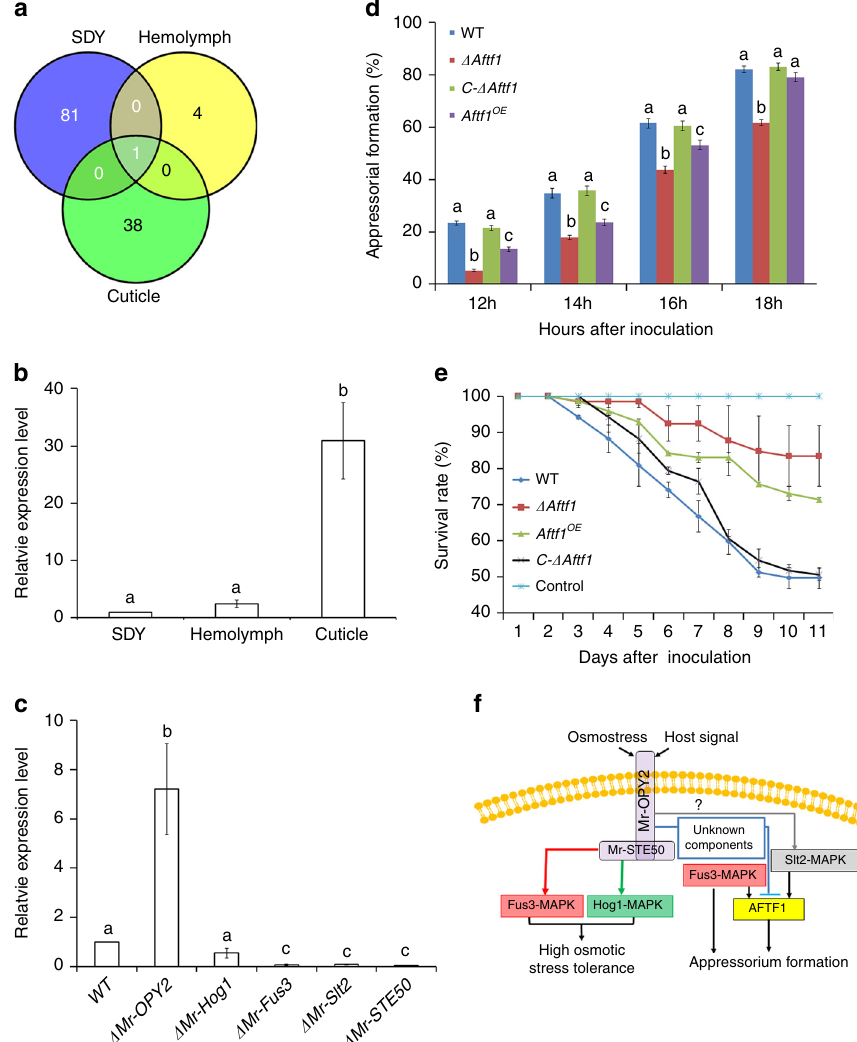
Fig. 7 Identi fi cation and characterization of the appressorial formation transcription factor AFTF1 and its negative regulation by Mr-OPY2. a Venn diagram of RNA-seq analysis showing the distribution of shared DEGs in transcriptomes of WT and Δ Mr-OPY2 during growth in SDY (SDY), the insect cuticle (Cuticle) and hemolymph (Hemolymph). Two biological repeats were established for each treatment. b qRT-PCR analysis of Aftf1 expression by the WT grown in hemolymph and on locust cuticle relative to expression during saprophytic growth in SDY (which is set to 1 in the fi gure). c qRT-PCR analysis of Aftf1 expression by the WT, Δ Mr-OPY2 , Δ Mr-STE50 , Δ Mero-Hog1, Δ Mero-Fus3 and Δ Mero-Slt2 during appressorial formation. The expression level in the WT is set to 1. The qRT-PCR analyses were repeated three times with three replicates per repeat. Data are expressed as the mean ± SE. Values with different letters are signi fi cantly different ( n = 3, P < 0.05, Tukey ’ s test in one-way ANOVA). d The % germlings differentiating appressoria on